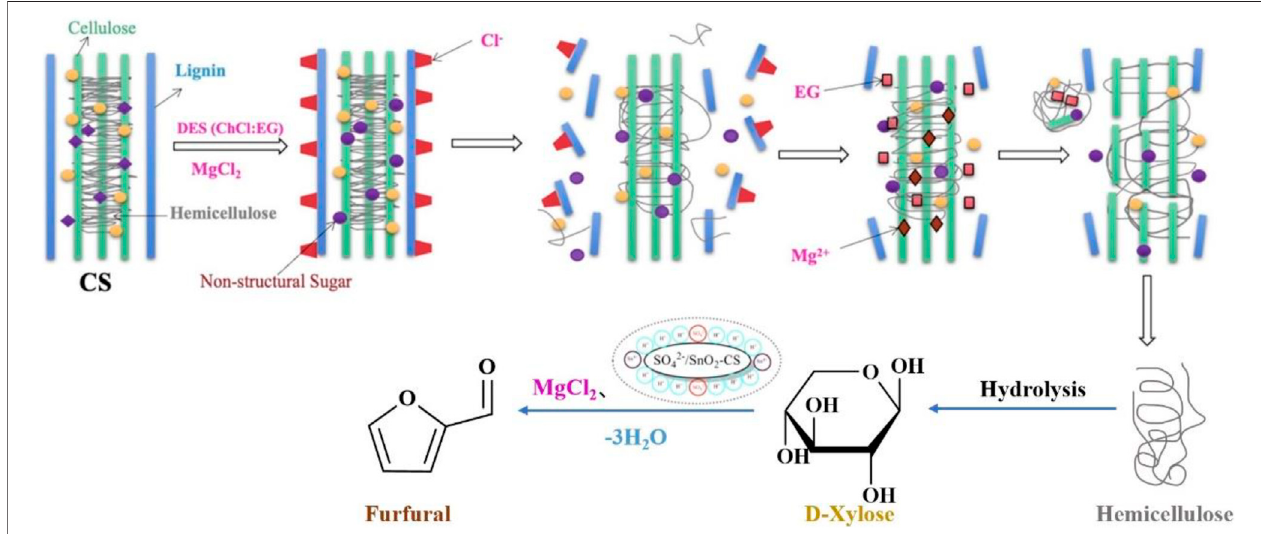
FIGURE4| Thecatalyticmechanismforcatalyzingcornstoverintofurfuralandbyproductsat170 ° Cfor0.5 hinChCl:EG – water(20:80,v:v).Reprintedfromref.(Ji et al., 2021). Copyright 2021 Elsevier Ltd.